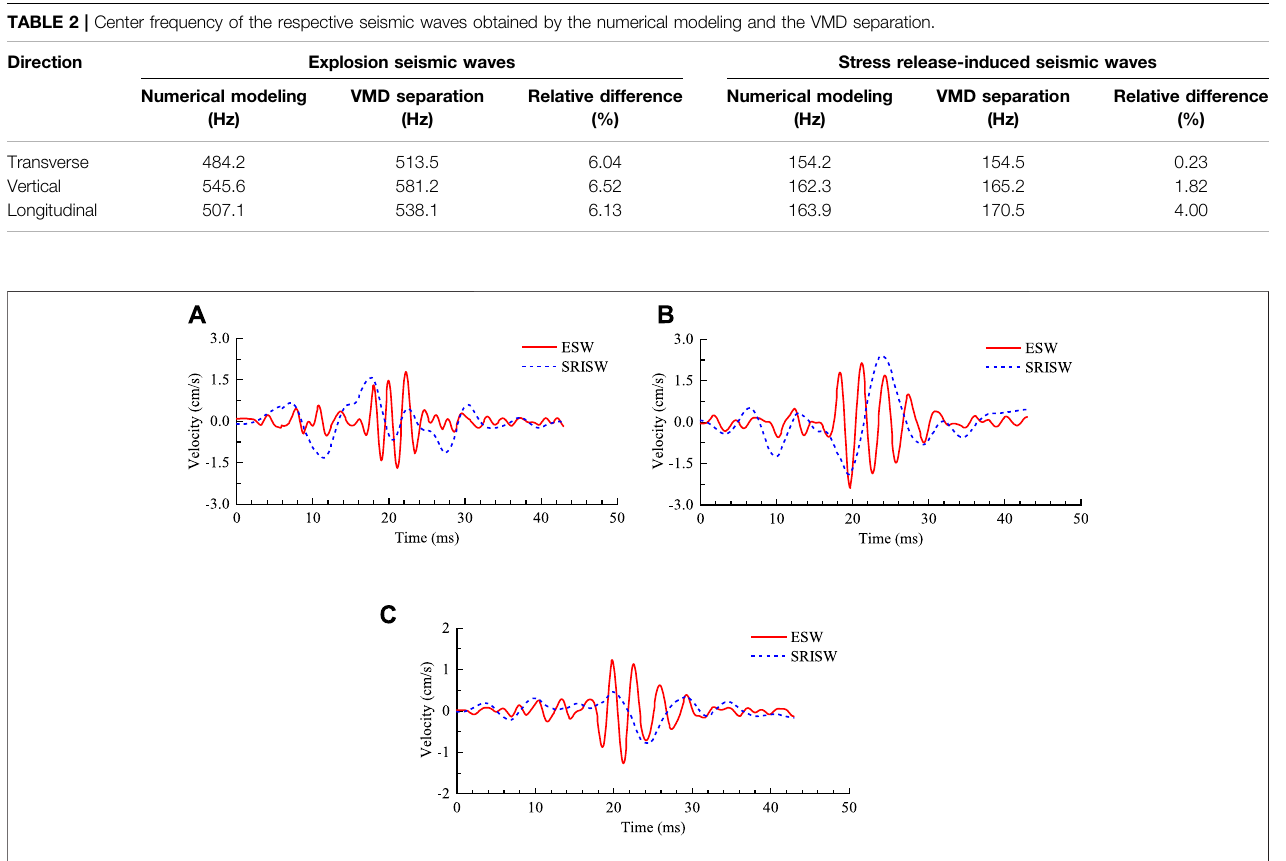
Frontiers in Earth Science |